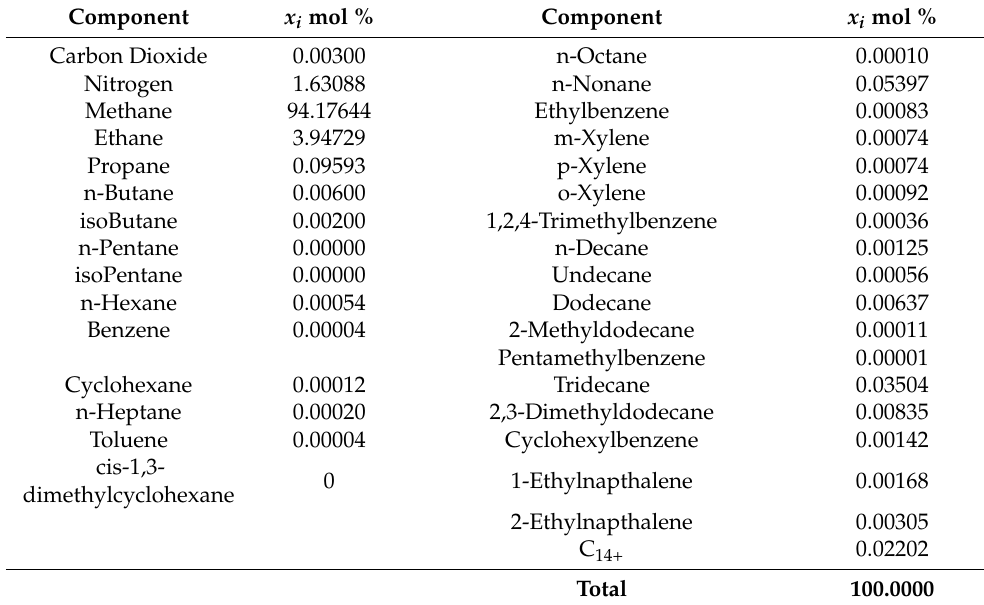
Table 7. Fully characterized composition of Sample 3 (Average Gas).